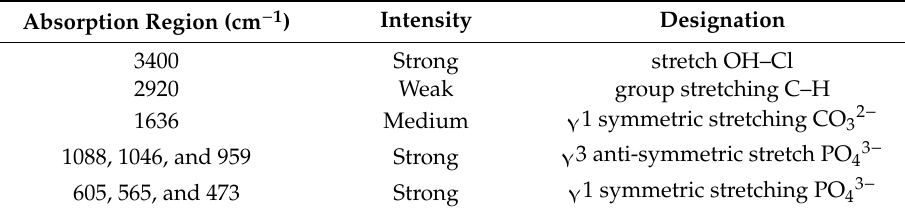
Table 2. Infrared absorption bands at ClAp600, 800, and